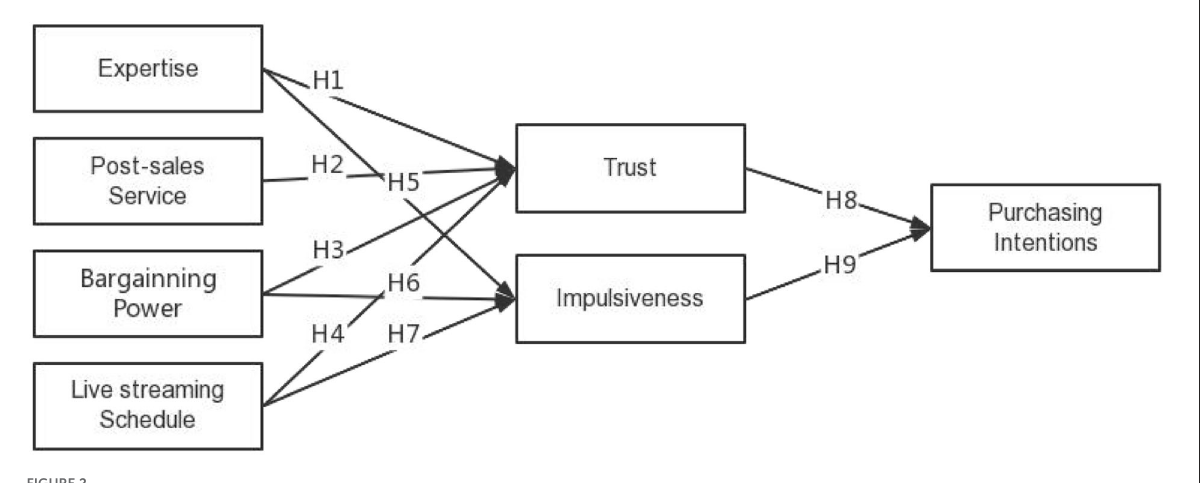
FIGURE2 Theoretical model in this